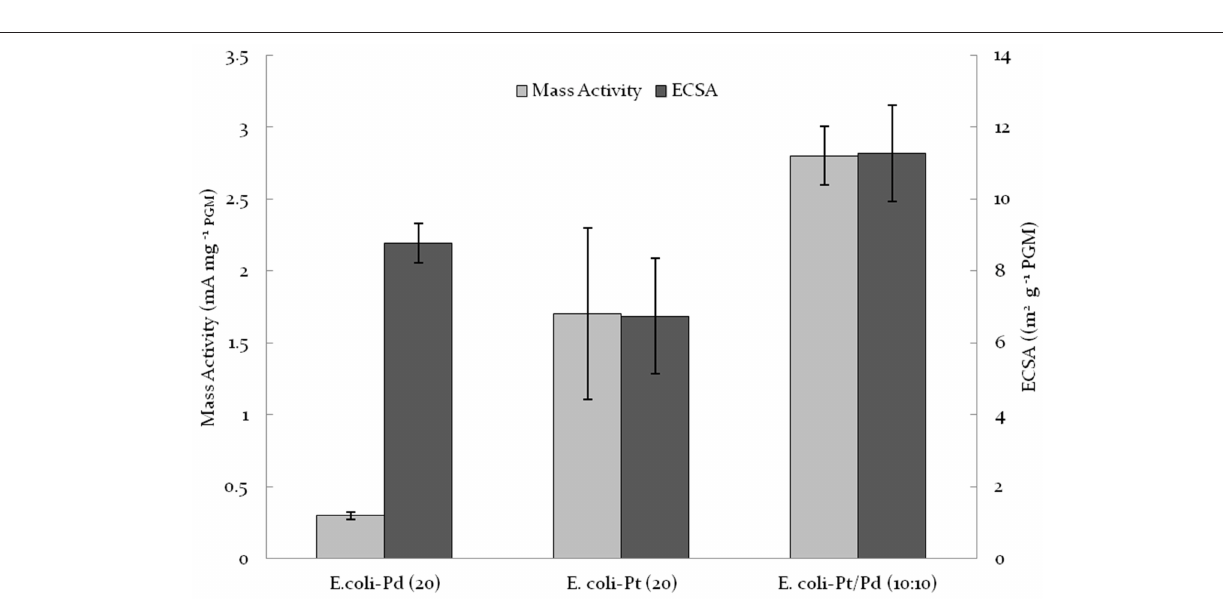
Frontiers in Energy Research |